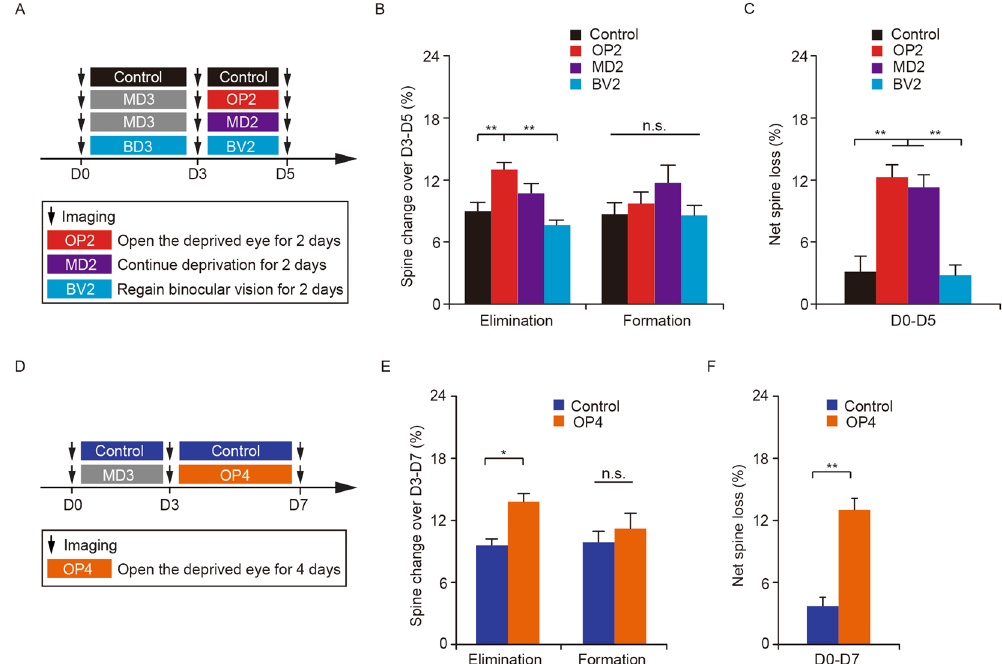
Figure 3. MD-induced spine elimination persists during subsequent binocular recovery. ( A ) Schematic of experimental paradigm. OP2 represents the condition in which the contralateral deprived eye was reopened for two days. MD2 represents continuous deprivation of the contralateral eye for two days and BV2 represents regaining binocular vision from BD for two days. ( B ) Percentage of dendritic spines eliminated and formed between days 3 and 5. The rate of spine elimination in OP2 mice (n = 1539 spines, 58 dendrites from 9 mice) was comparable to that in MD2 mice (n = 1349 spines, 58 dendrites from 8 mice), but significantly higher than that in non-deprived control mice (n = 1067 spines, 42 dendrites from 6 mice) and BV2 mice (n = 839 spines, 38 dendrites from 5 mice). No significant difference in the rate of spine formation was observed among the four groups. ( C ) Changes in spine number over five days under various conditions. The degree of net spine loss in OP2 mice (n = 9) was comparable to that in MD2 mice (n = 7), but significantly higher than that in non-deprived mice (n = 6) and BV2 mice (n = 5). ( D ) Schematic of experimental design. OP4 represents the condition in which the contralateral deprived eye was reopened for four days. ( E ) Percentage of dendritic spines eliminated and formed between days 3 and 7. The rate of spine elimination in OP4 mice (n = 871 spines, 34 dendrites from 5 mice) was significantly higher than that in non-deprived control mice (n = 964 spines, 58 dendrites from 6 mice). There was no significant difference in spine formation between OP4 and control mice. ( F ) The degree of net spine loss in OP4 mice (n = 5) was significantly higher than that in non-deprived mice (n = 6). Data are presented as mean ± SEM. * P < 0.05, ** P < 0.01, n.s. = not